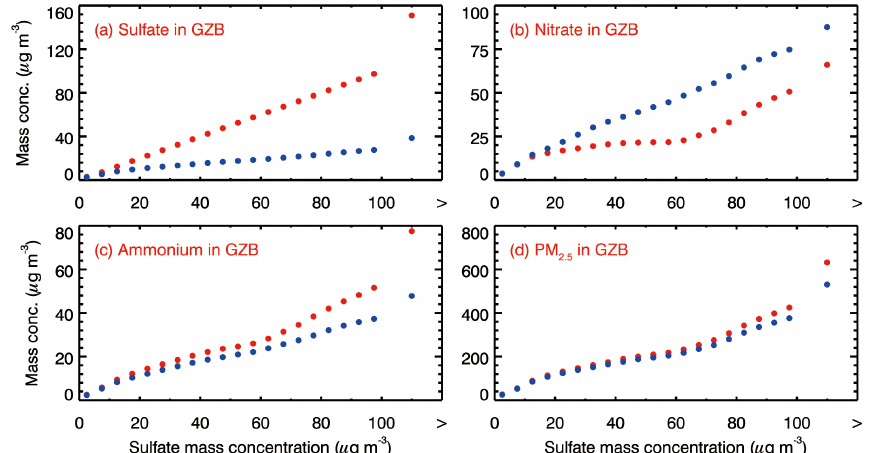
Figure 17. Average (a) sulfate, (b) nitrate, (c) ammonium, and (d) PM 2 . 5 mass concentrations in GZB during the simulation period as a function of the sulfate mass concentration in the E-case. The red and blue dots represent average mass concentrations in the E-case and B-case, respectively.